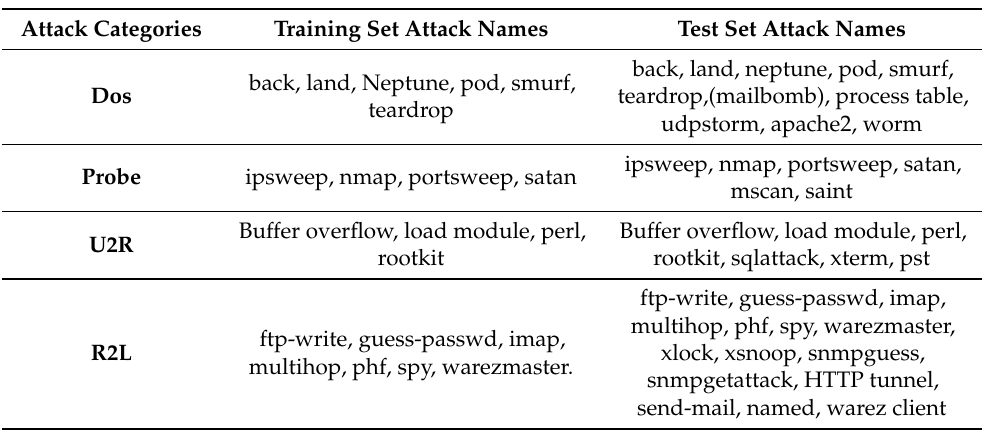
Table 3. Attack types in the NSL-KDD dataset and their